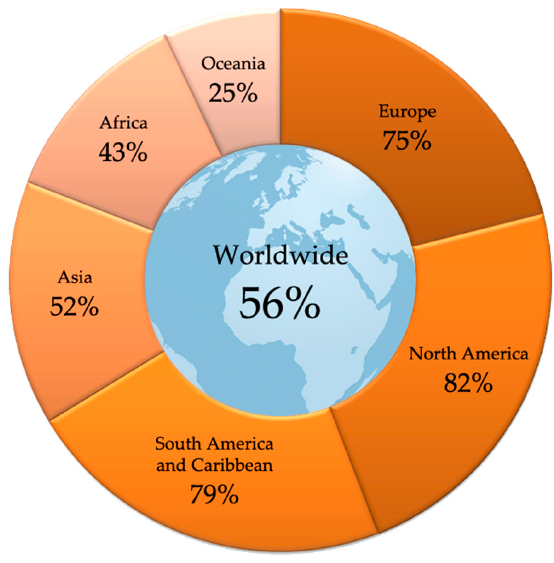
Figure 1. Global urbanization percentage per continent.